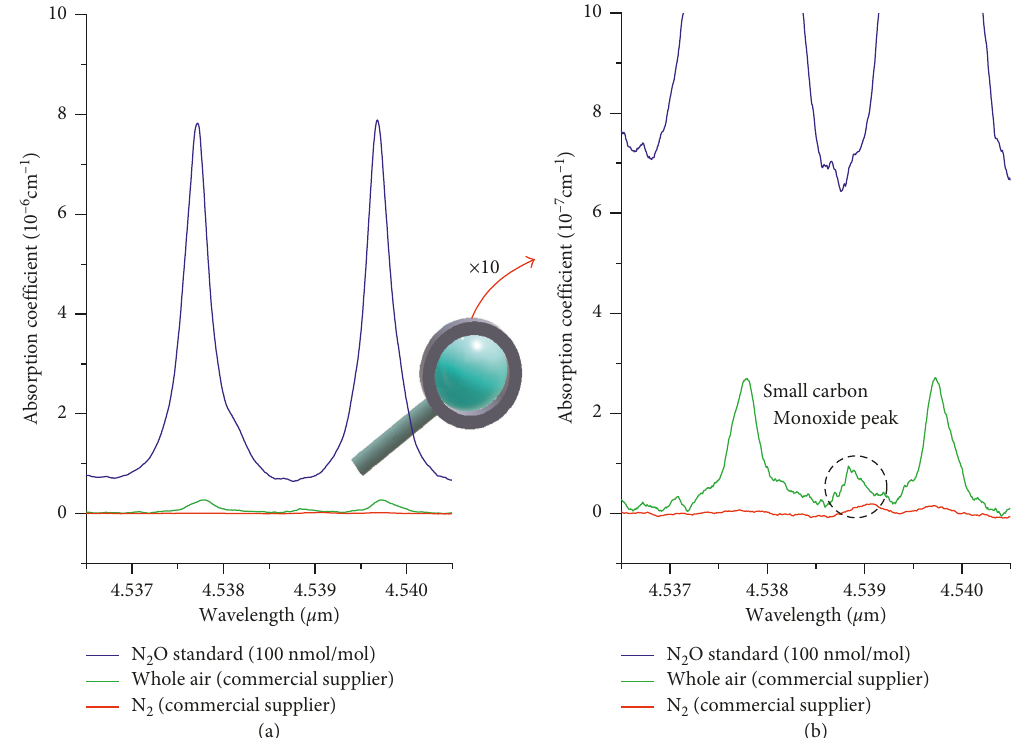
Figure 4: (a) Measurement of a 100nmol/mol N 2 O standard, a cylinder of whole air, and a cylinder of nitrogen. (b) 10x magnification of (a) showing more clearly the presence of N 2 O in whole